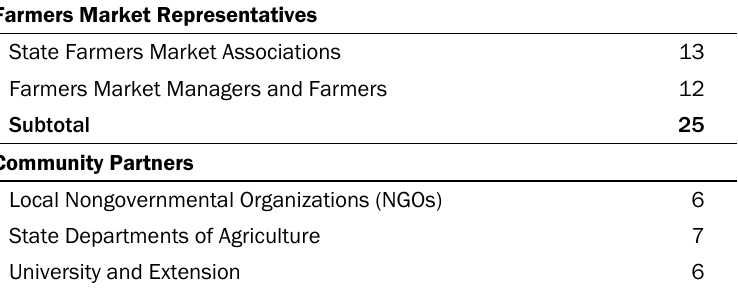
Figure 2. Stakeholder Affiliations at USDA National Farmers Market Summit, March